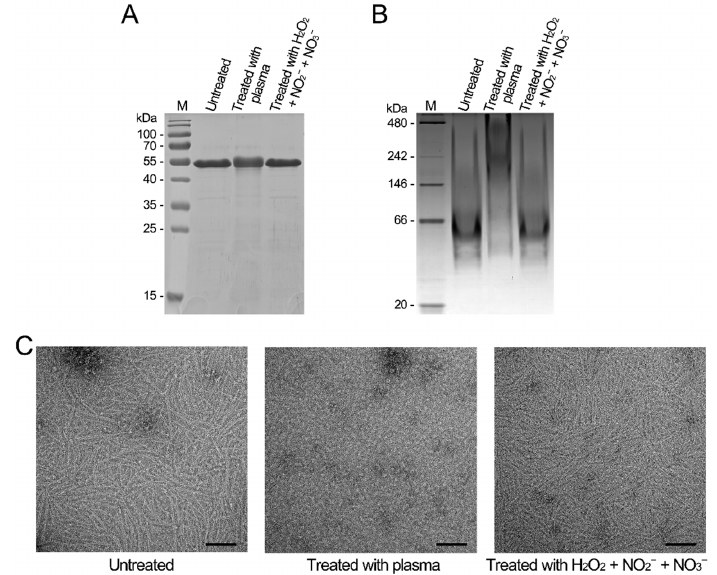
Figure 4. Inactivation of SaFtsZ by plasma treatment in vitro. ( A ) The plasma-treated, H 2 O 2 + NO 2 − + NO 3 − -treated, and untreated SaFtsZ proteins separated by SDS-PAGE. ( B ) The plasma-treated, H 2 O 2 + NO 2 − + NO 3 − -treated, and untreated SaFtsZ proteins separated by blue native PAGE. The SDS-PAGE or blue native PAGE was stained with Coomassie Brilliant Blue R-250. M, molecular weight standards with molecular weights indicated. ( C ) Self-assembly of SaFtsZ proteins. The plasma-treated, H 2 O 2 + NO 2 − + NO 3 − -treated, and untreated SaFtsZ proteins were self-assembled in the presence of GTP. Then, the samples were negatively stained and examined using transmission electron microscopy (TEM). The denatured CAP-treated SaClpP protein migrated more slowly than the untreated SaClpP protein (Figure 5A). The untreated SaClpP protein exhibited tetradecamers and heptamers, and the CAP-treated SaClpP protein became a larger smear probably formed by large polymers (Figure 5B). To further evaluate the effect on proteins, peptidase activity against peptide substrates was tested. The cleavage of the dipeptide (N-succinyl-Leu-Tyr- 7-amido-4-methylcoumarin) by CAP-treated SaClpP was hardly detectable, suggesting that the peptidase activity of the SaClpP protein was inactivated by the CAP treatment (Figure 5C). These results indicated that the CAP treatment caused polymerization and inactivated the activity of the SaFtsZ and SaClpP proteins in vitro.